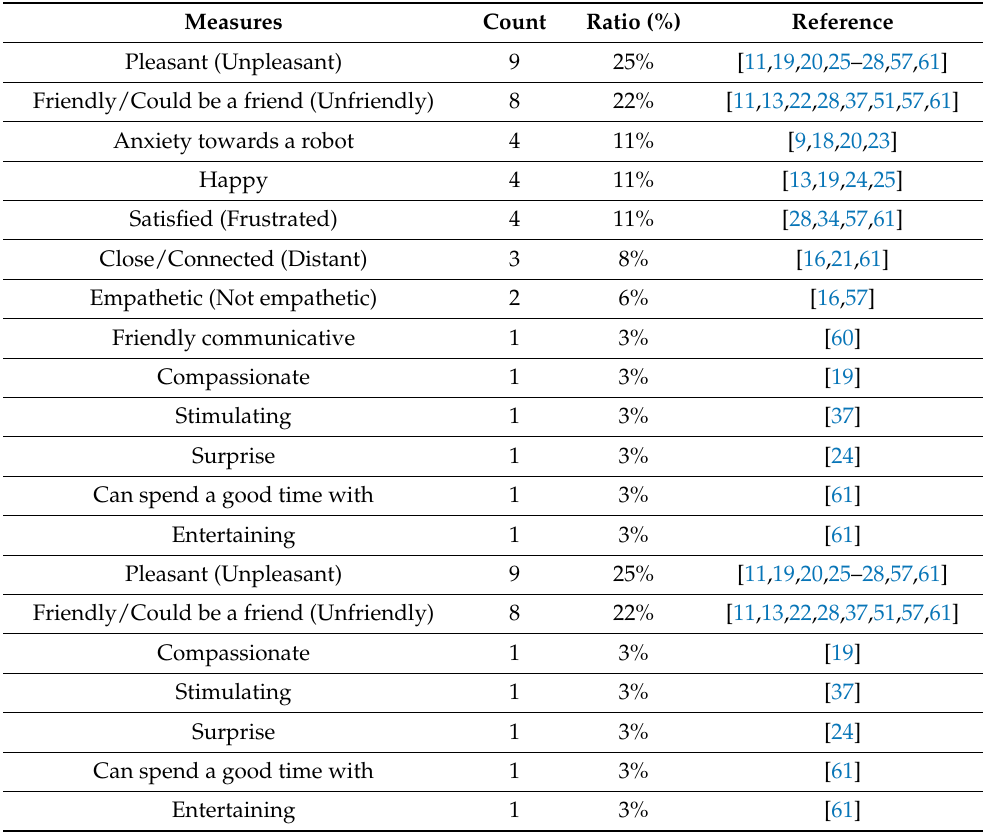
Table 9. Perceived emotional value of a robot.